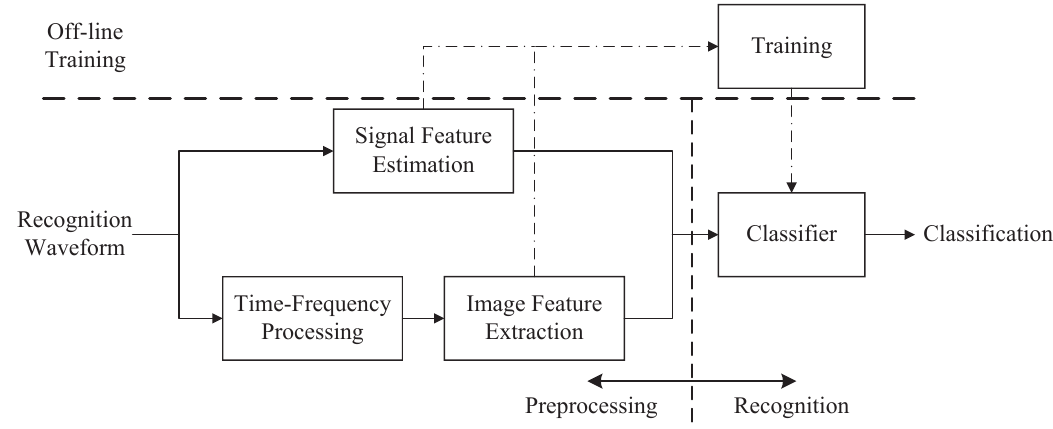
Figure 1. The figure has shown the system components. The adding white noise σ 2 ε is estimated in signal feature